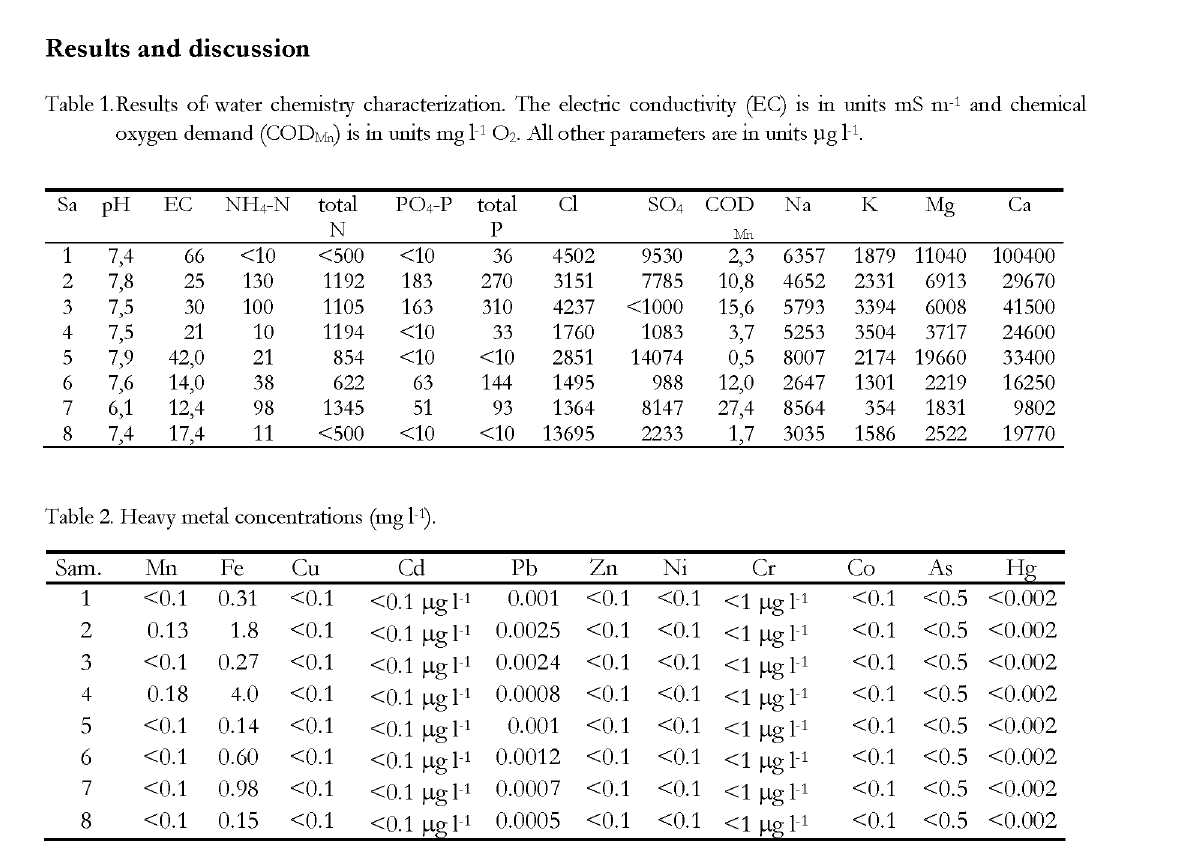
Table 2. Heavy metal concentrations (mg l -1 ).